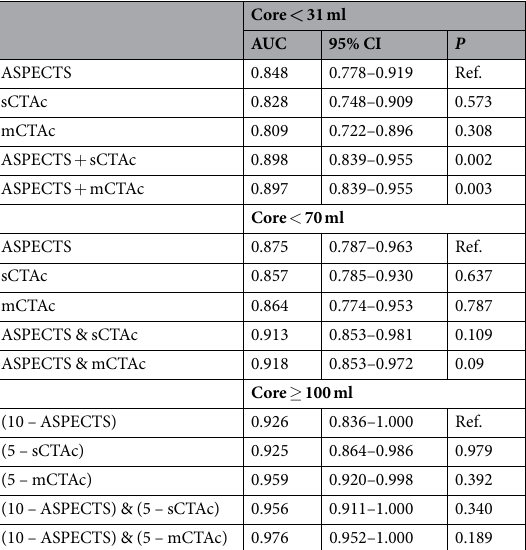
Core < 31 ml AUC 95% CI P